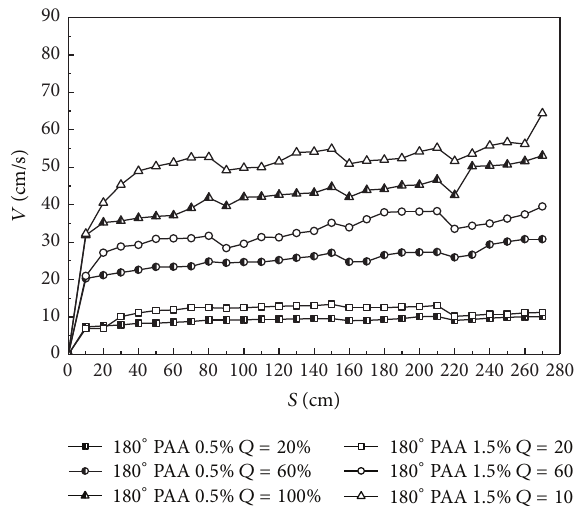
Figure 13: The PAA velocity-position diagram of various flow in 180 ∘ curved tube.